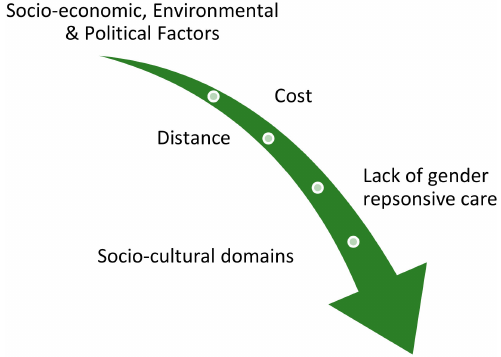
Figure 2. Social Determinants of Health Domains from Formative